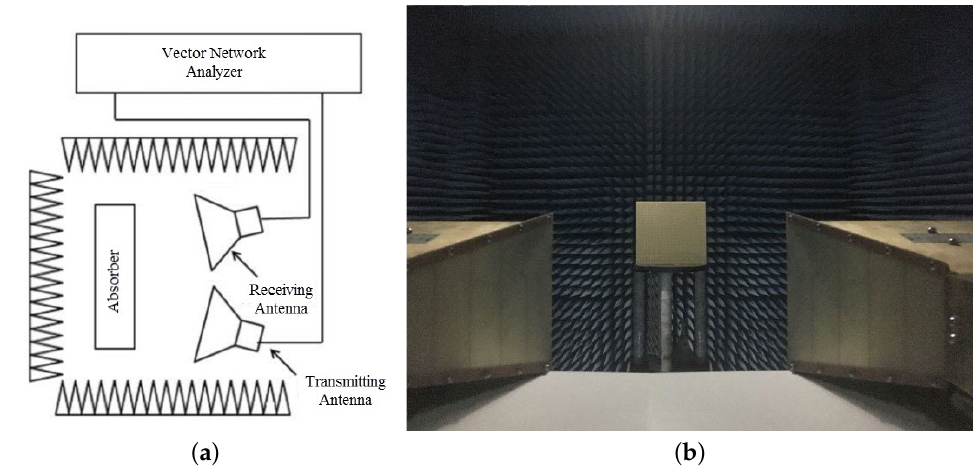
Figure 9. ( a ) Schematic diagram of measurement environment ( b ) Actual measurement